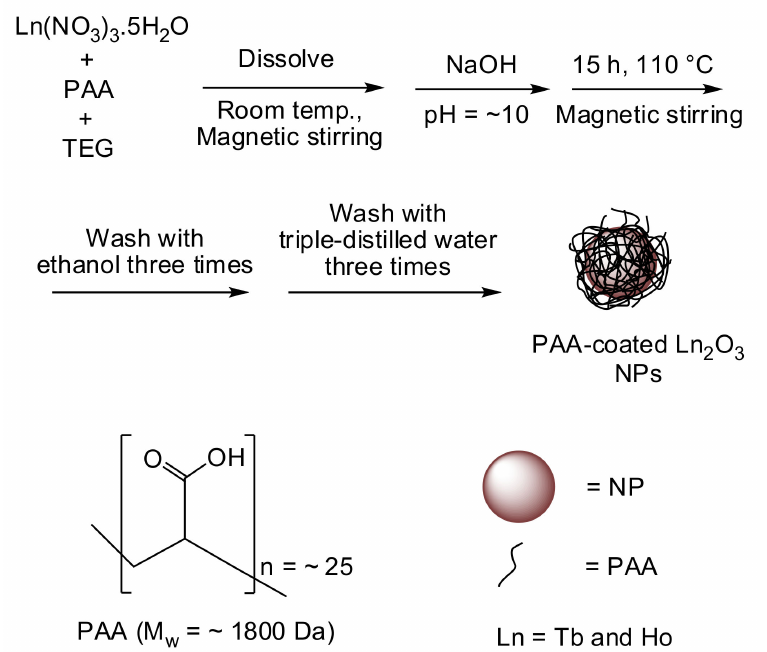
Figure 1. One-pot polyol synthesis of the PAA-coated Ln 2 O 3 NPs (Ln = Tb and